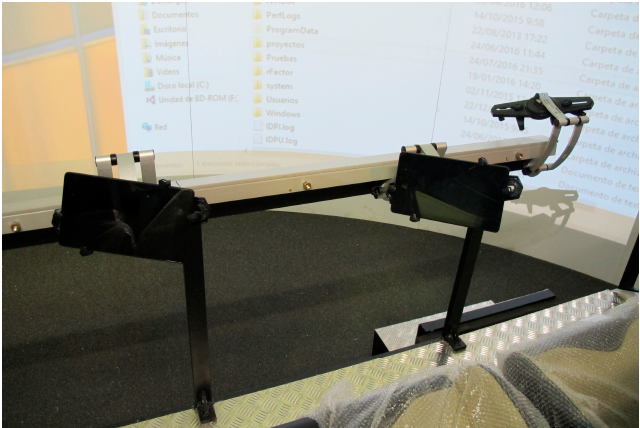
Figure 2. Image where the curved screen can be appreciated. Some tablets are also in their place.